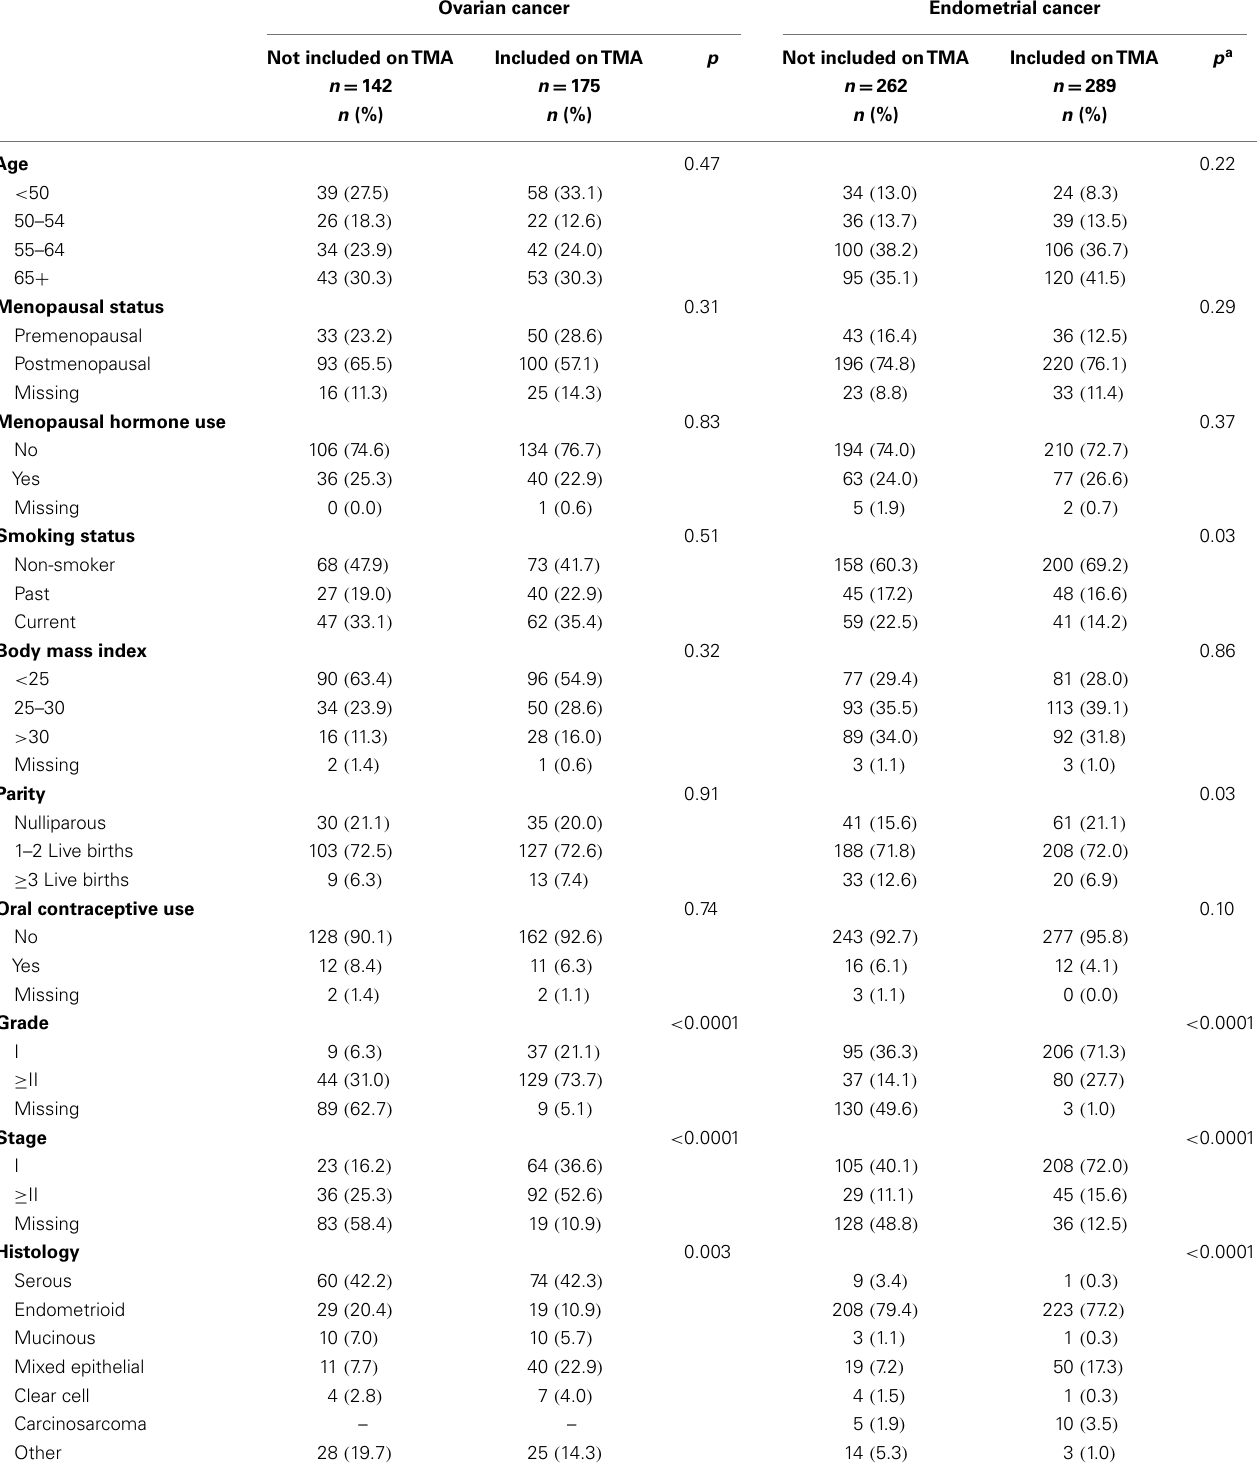
Table 1 | Selected characteristics of ovarian and endometrial cancer cases in the Polish Cancer Study by inclusion on the tissue microarray (TMA)